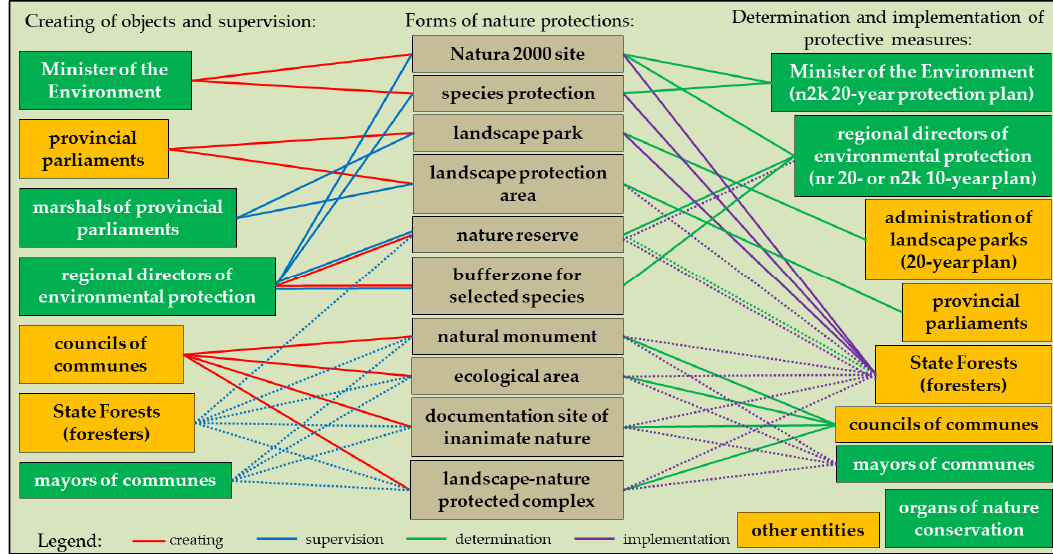
Figure 1. Organization of nature conservation in the State Forests (solid line—permanent solution, dotted line—possible solution).